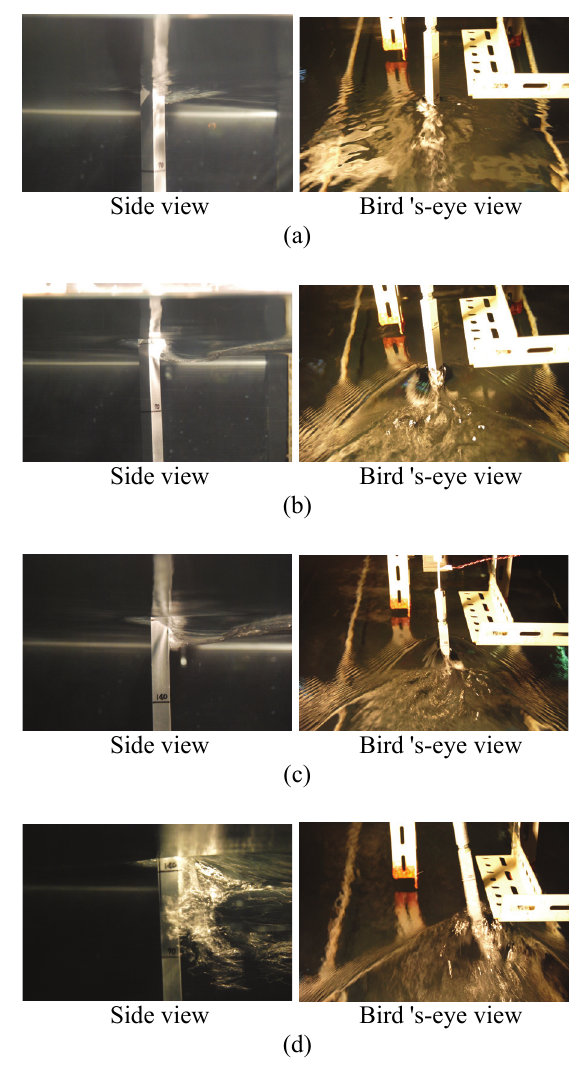
Fig. 8. Flow feature around square cylinder, (a) sharp square cylinder (S. S.), flow velocity; 0.29 m/s, (b) sharp square cylinder (S. S.), flow velocity; 0.6 m/s, (c) Flat square cylinder (F. S.), flow velocity; 0.6 m/s, (d) Flat square cylinder (F. S.), flow velocity; 1.02